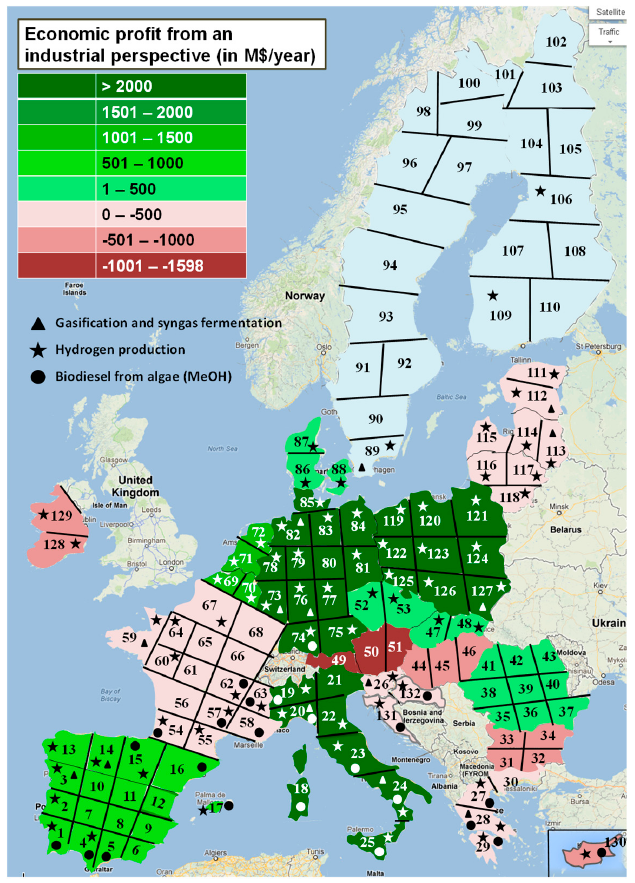
Figure 3. Economic profit from an industrial perspective and locations of the selected technologies when maximizing sustainability profit.